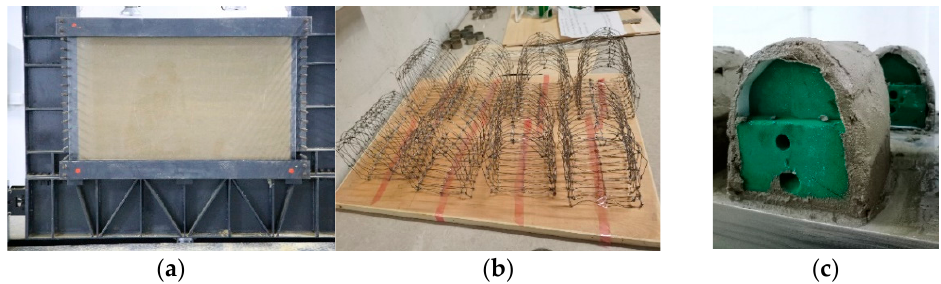
Figure 14. Model making: ( a ) model soil, ( b ) grid steel frame model, and ( c ) primary support. During the test, pilot tunnels were excavated one by one in the following order: 5-7-6-8-1-3-4-2, as shown in Figure 15. Excavating in this order mainly considers that the construction sequence had little effect on the stress distribution laws in the previous study and ensures the stability of model during excavation.